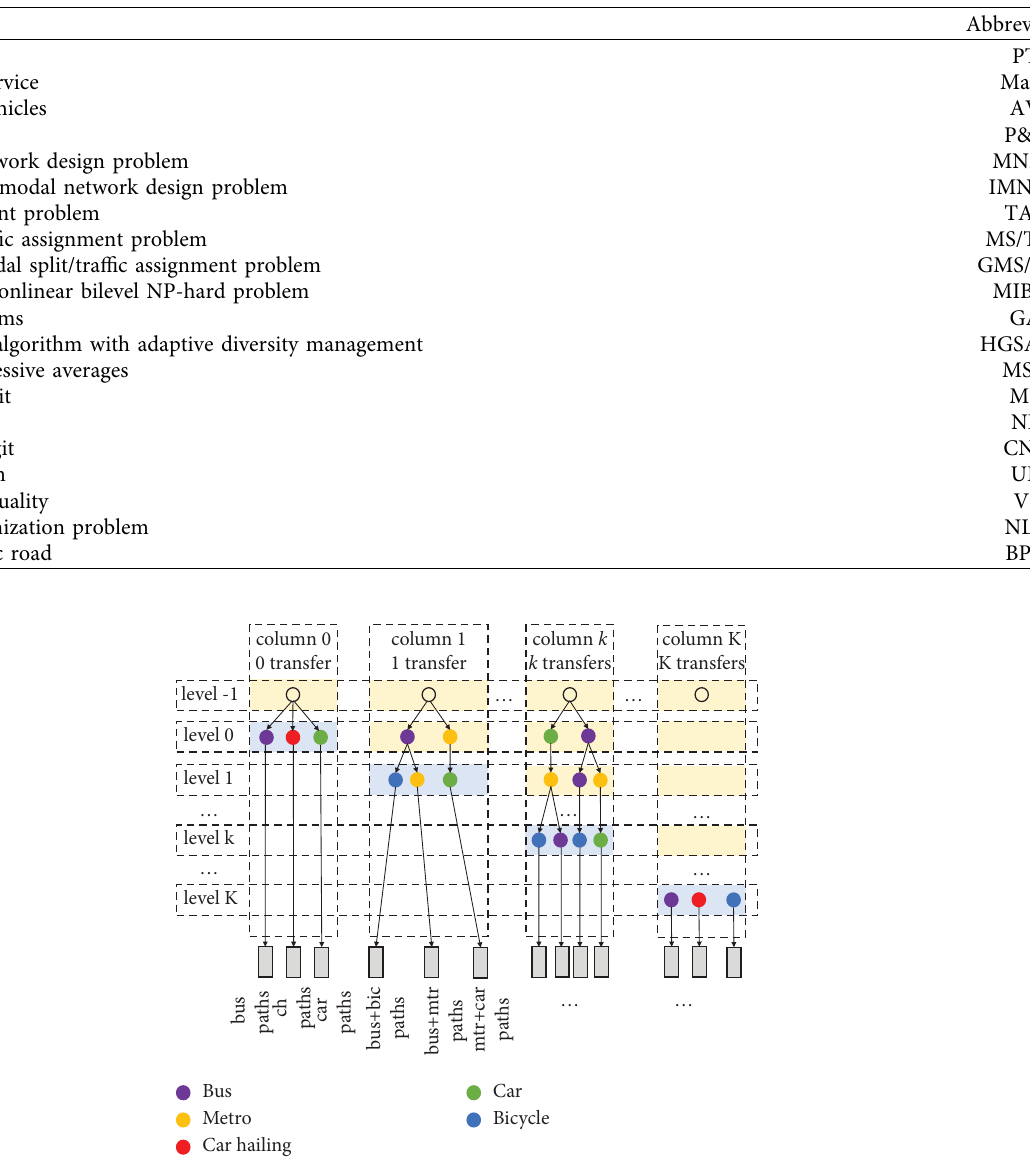
Table 1: List of abbreviations.